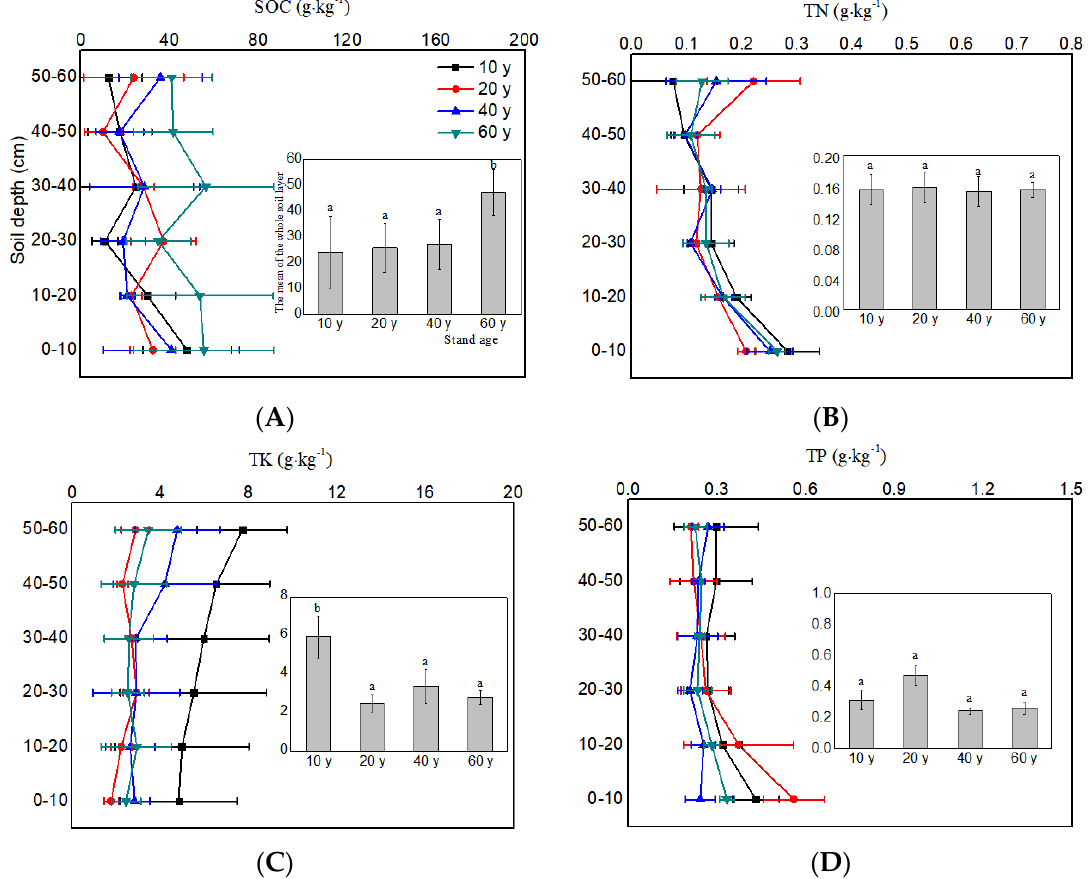
Figure 3. Content of soil organic carbon, total nitrogen, total phosphorus, and total potassium in different-aged forests. Different small letters indicate significant differences ( p < 0.05). The histogram displays the average value from 0 to 60 cm and the curve shows the measured value from 0 to 60 cm. SOC, TN, TK, and TP represent soil organic carbon, total nitrogen, total potassium, and total phosphorus, respectively. ( A – D ) represents soil organic carbon, total nitrogen, total potassium, and total phosphorus, respectively.